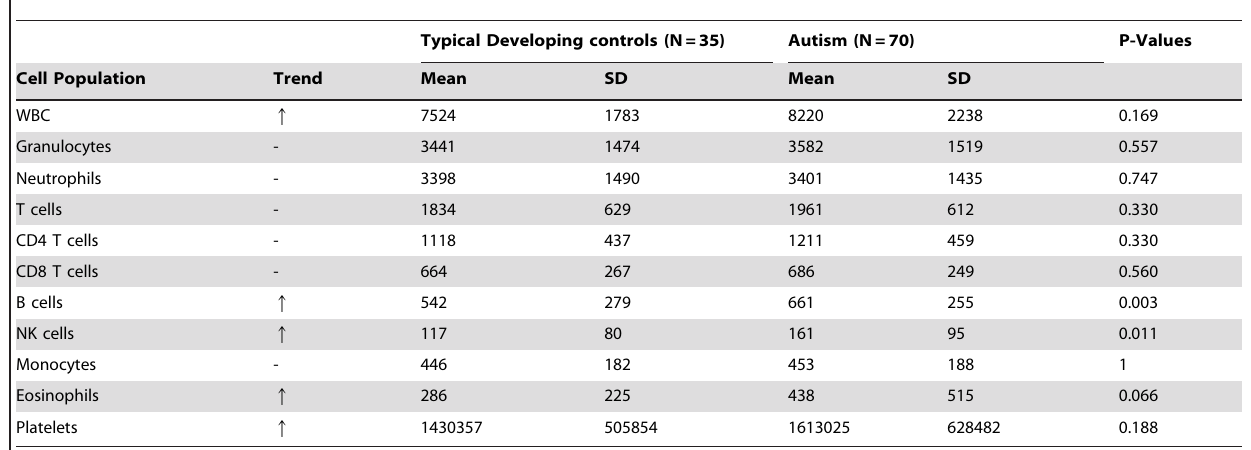
Table 5. Comparison of major blood cell populations between Autism and Typical groups.